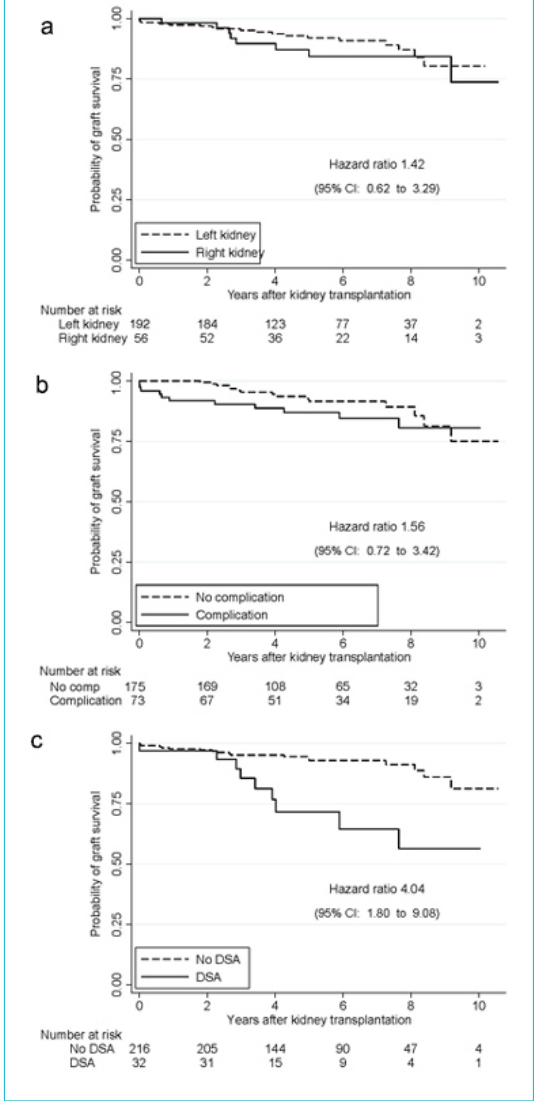
Figure 2: Death-censored graft survival according to side of kid- ney (a), occurrence of surgical complications (b) and presence of donor-specific antibodies (DSA)